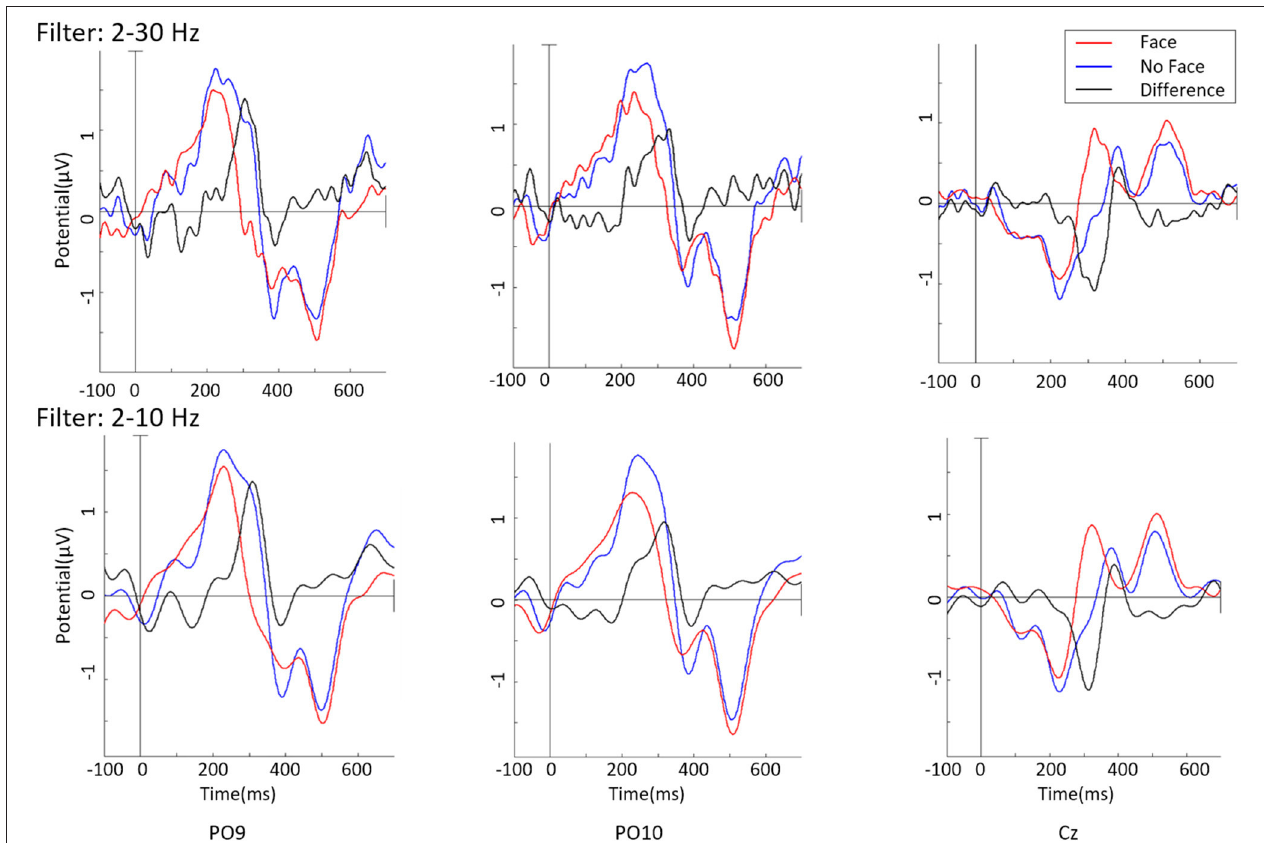
FIGURE 2 | Grand average ERPs on the Channel PO9, PO10, and Cz with different bandpass